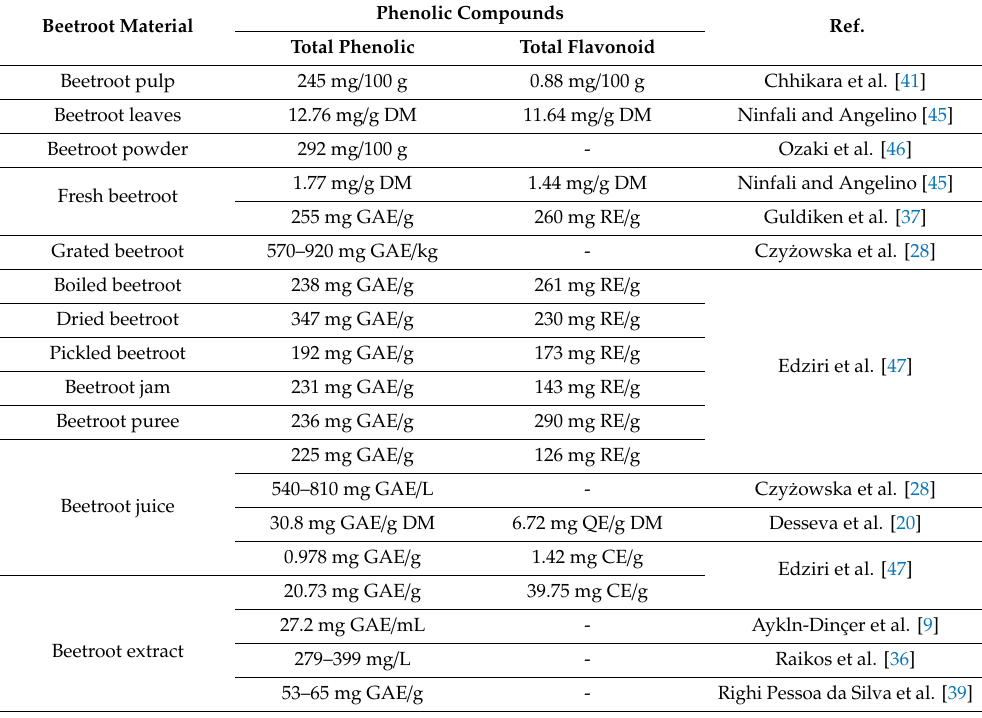
Table 3. Total phenolic and total flavonoid contents in di ff erent beetroot